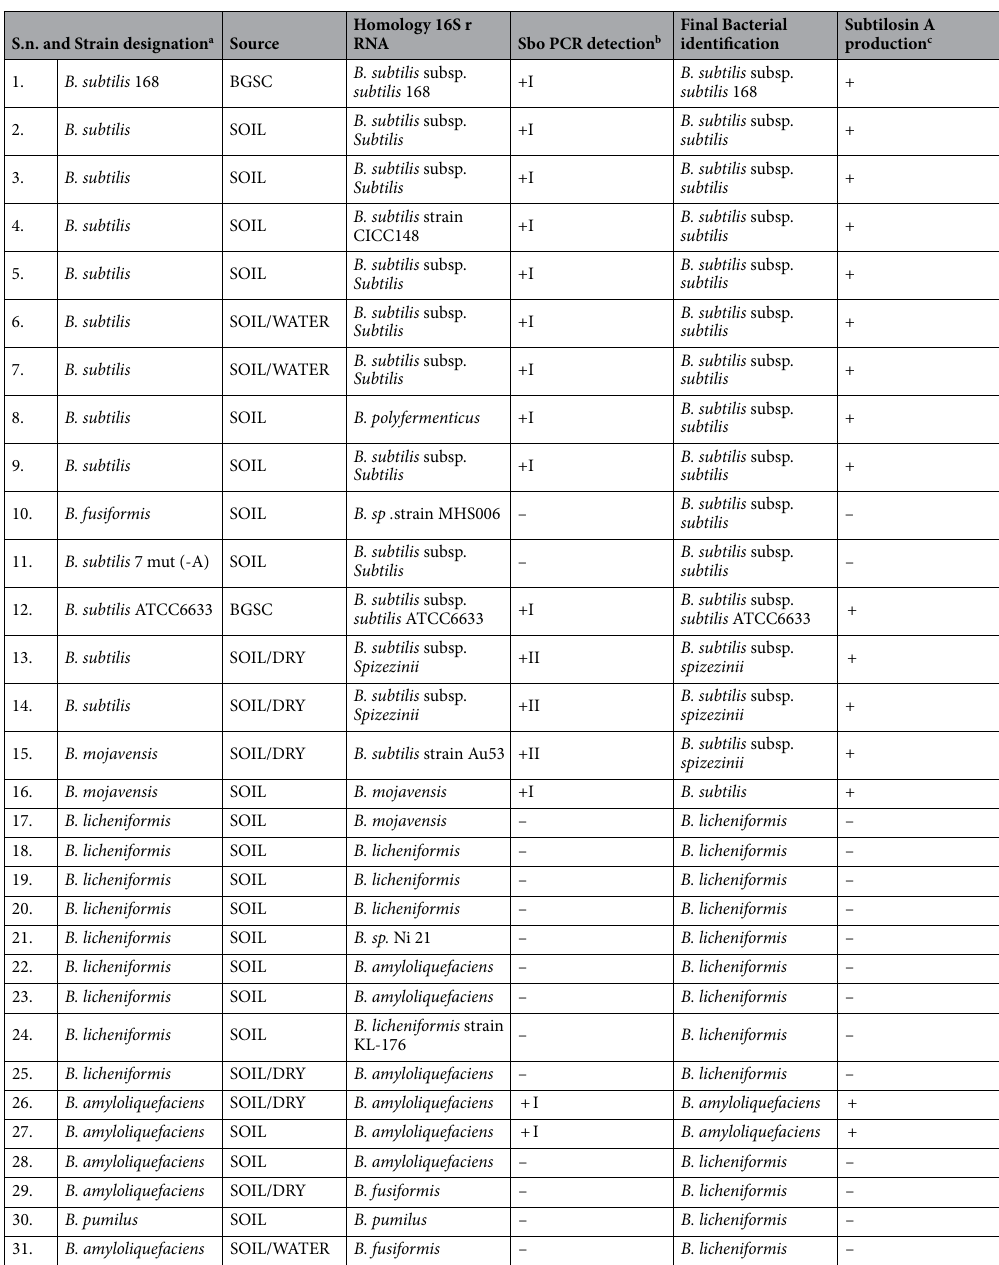
Table 1. Identification of Bacillus strains used through 16S rRNA, sbo and biochemical characterization through CHB-50 PCR of. Subtilosin A production was also noted for correlation. a Identification by using CHB-50. b + PCR product of the expected size was detected. I and II assigned for subsp. subtilis and spizizenii